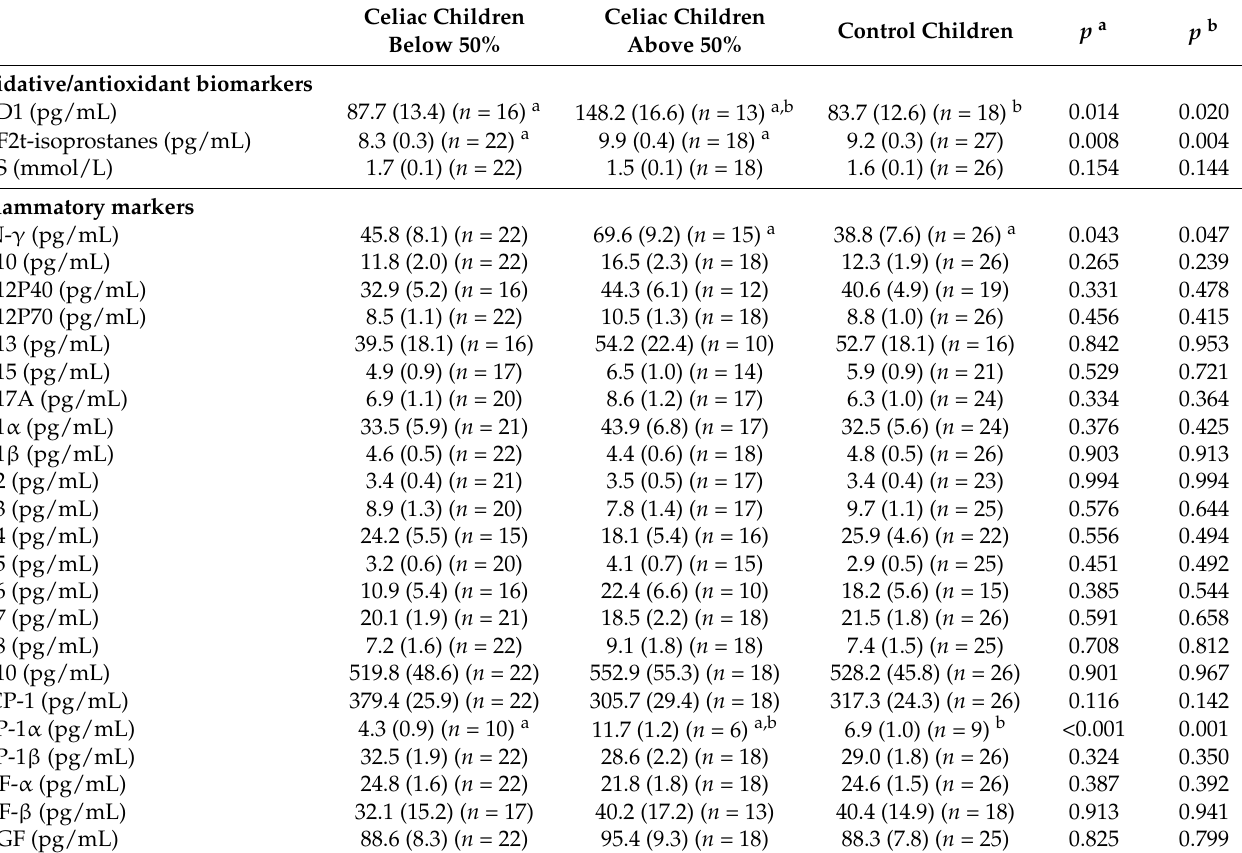
Table 3. Differences in oxidative/antioxidant biomarkers and inflammatory profiles in celiac children by percentage of energy intake from ultra-processed foods (below 50% vs. above 50%) and control